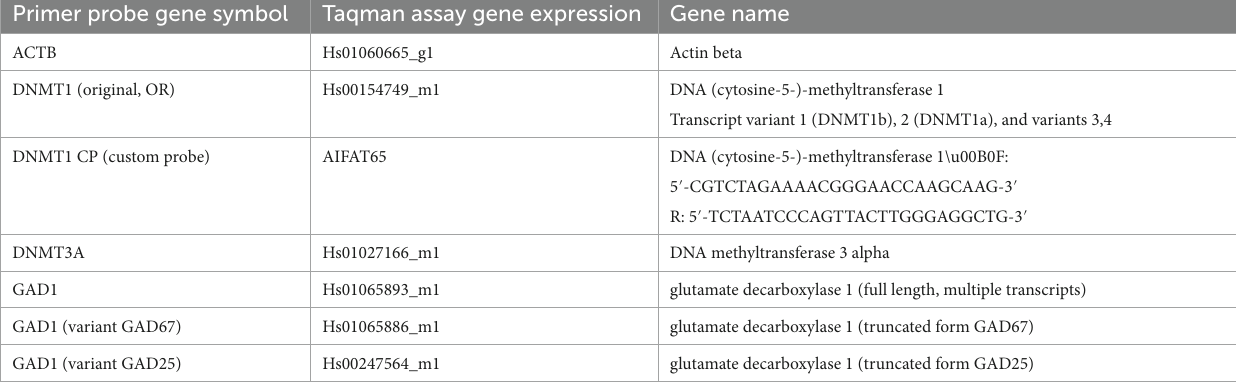
TABLE 2 Gene symbols and TaqMan primers. Primer probe gene